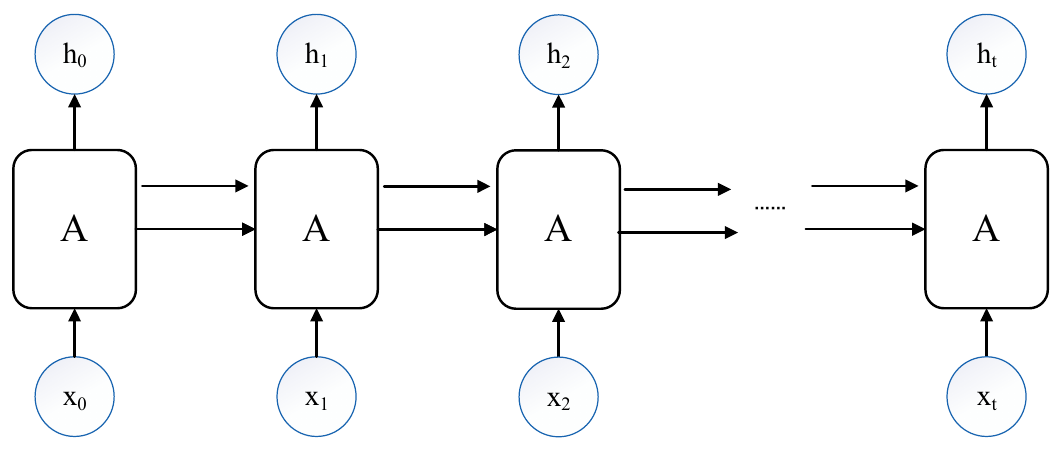
Figure 5. The main structure of LSTM. In Figure 5, x 0 , x 1 , x 2 , . . . . . ., x t are the inputs at time 0, 1, 2, . . . . . . t ; A is an LSTM unit, which is constructed by different components with one memory cell and four gates (input, forget, cell, and output) [41]. h 0 , h 1 , h 2 , . . . . . . h t are outputted by A , which represent the hidden state of time 0, 1, 2, . . . . . . t . Supposing the network includes N hidden layers, the prediction process of a new